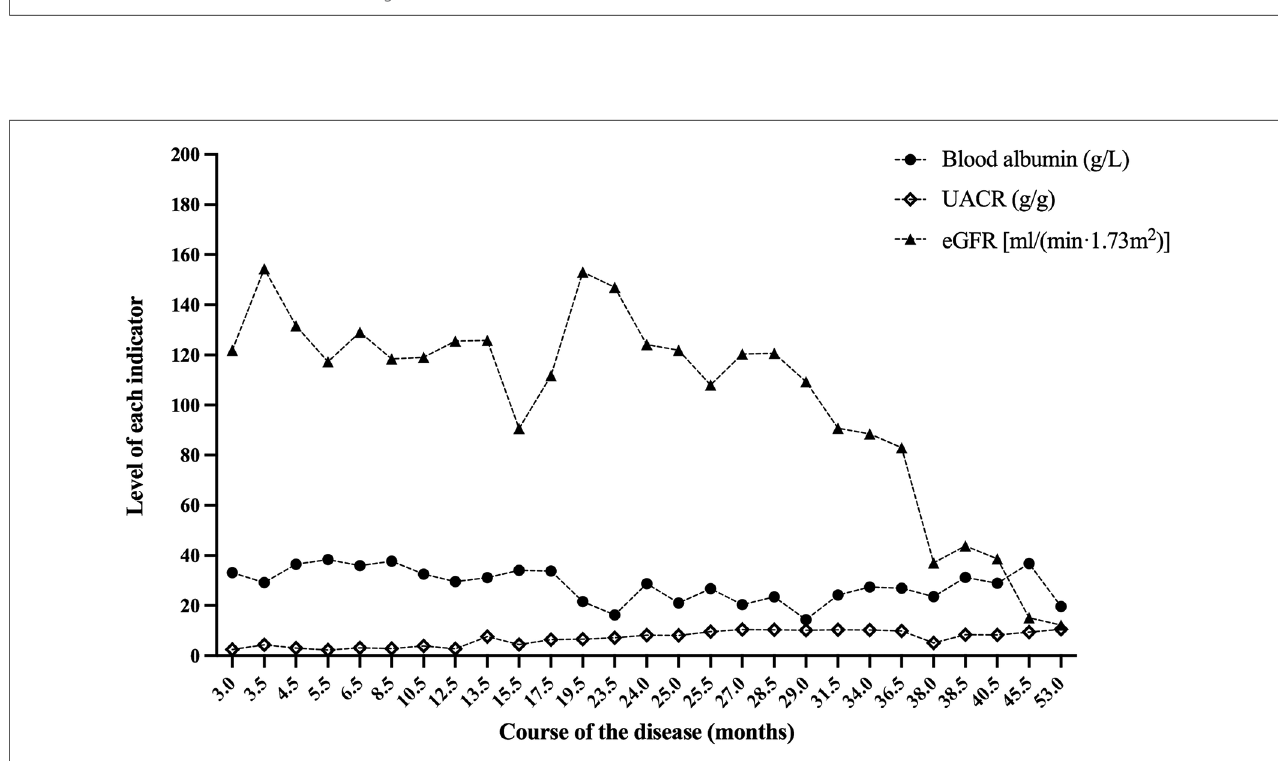
FIGURE 3 Blood albumin, UACR and eGFR at the follow-up of case 2. After 53.0 months of follow-up, the eGFR of case 2 was 12.2 ml/(min×1.73 m 2 ). UACR, urinary albumin to creatinine ratio; eGFR, estimated glomerular fi ltration